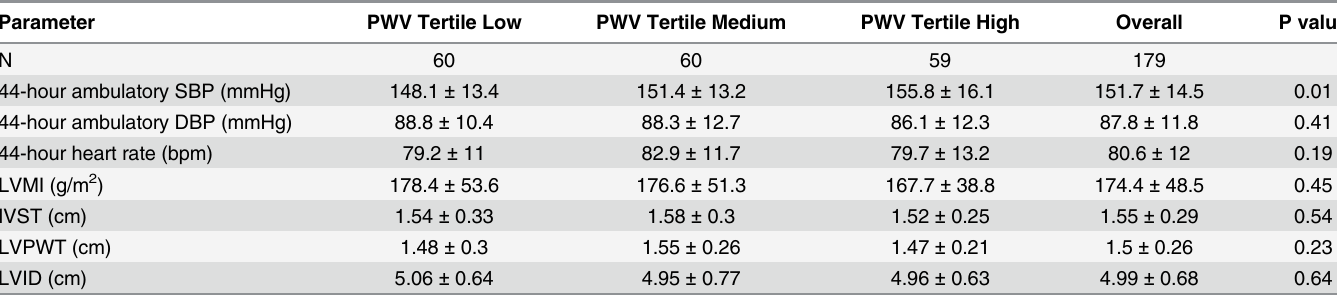
LVMI. Table 4 and Fig 1 show the predictors of LVMI change over time. In unadjusted analysis, significant effect of visits indicates that LVMI was significantly reduced from baseline to 6 months ( β -26.2 g/m 2 ; p = 0.03) and from baseline to 12 months ( β -35.7 g/m 2 p = 0.01). The interaction term of PWV x visit was not significant indicating no association of PWV with regression of LVMI. The aortic PWV was neither associated with LVMI at baseline ( β -1.6 g/m 2 Table 3. Interdialytic ambulatory BP and indices of left ventricular structure at baseline.